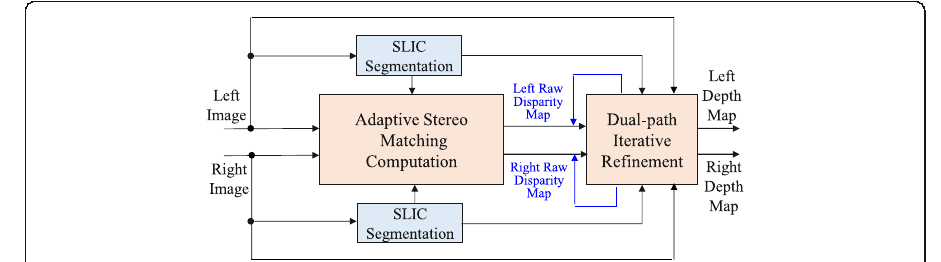
Fig. 4 Kernels of the proposed stereo matching system